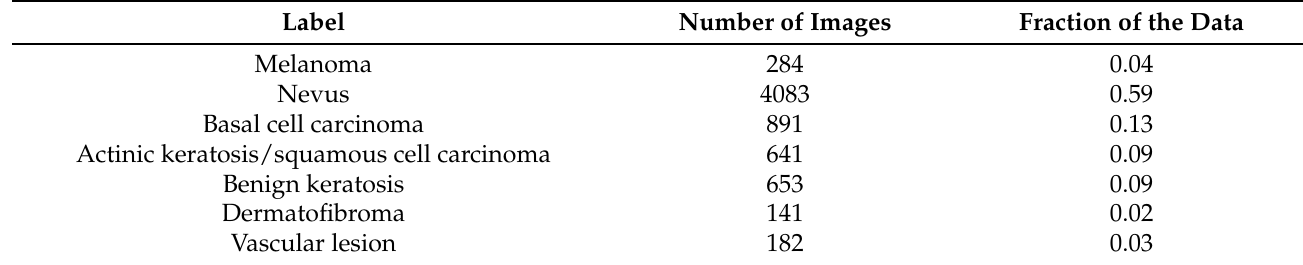
Table 1. Distribution of the labels in the Demetra